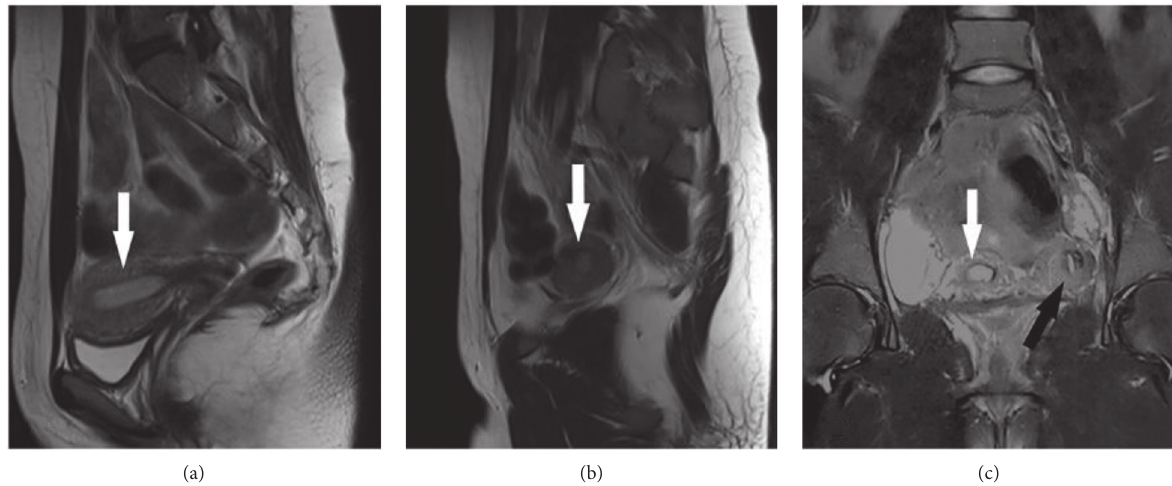
Figure 4: (a, b) Sagittal T2-weighted images of the pelvis reveal the uterus and the accessory and cavitated uterine mass, respectively. (c) Coronal T2-weighted image of the pelvis demonstrates the uterus on the right side (white arrow) and the accessory and cavitated uterine mass on the left side (black arrow), which are separate from each other.